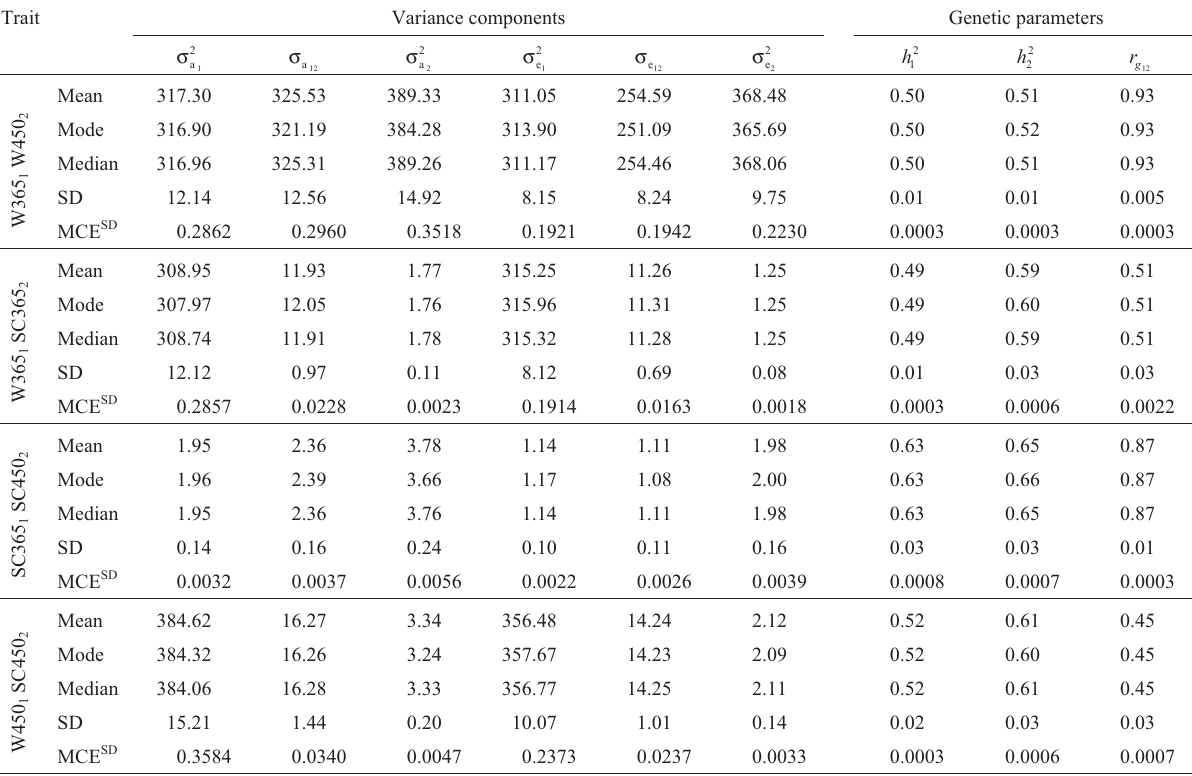
Table 3 - Descriptive statistics for variance components and heritabilities estimates for weight at 365 days of age (W 365 ) and 450 (W 450 ), scrotal circumference at 365